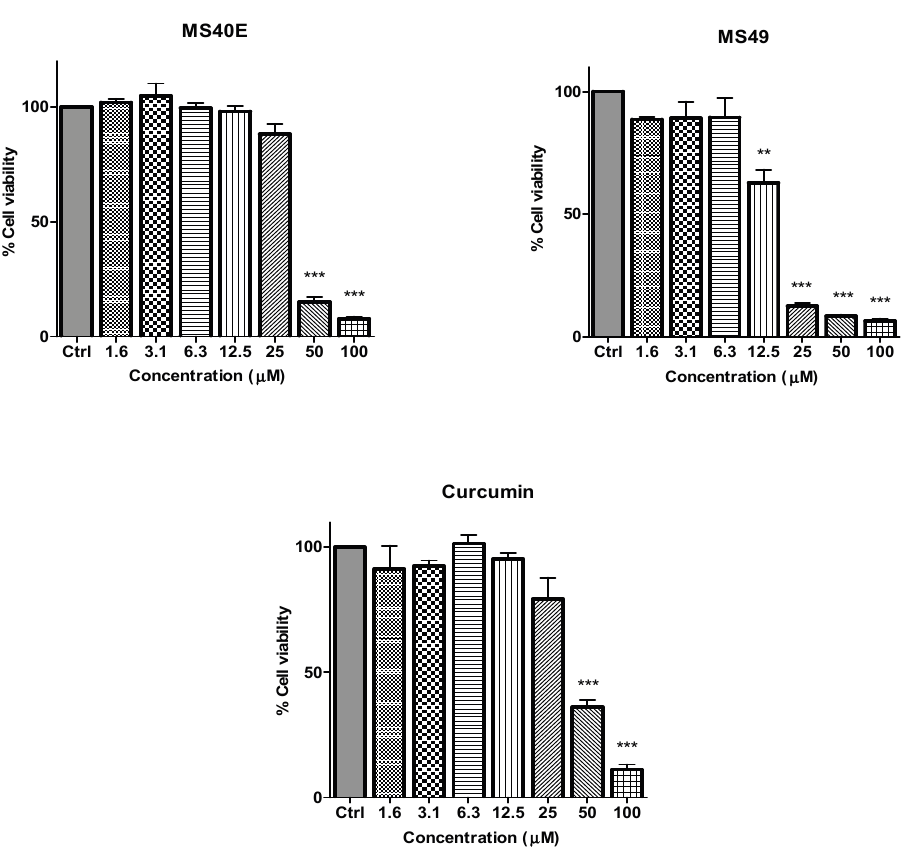
Figure 2. The inhibitory effects of cell viability by curcumin, MS17, MS13, MS40E and MS49 in PC-3 cell line compared to untreated sample (Ctrl). Results are expressed as means ± S.E. from three independent experiments. Percentage cell viability and comparison between data sets performed using ANOVA. * p < 0.05, ** p < 0.01 and *** p < 0.001 indicates statistically significant differences between the means of values obtained with treated vs. untreated cells.